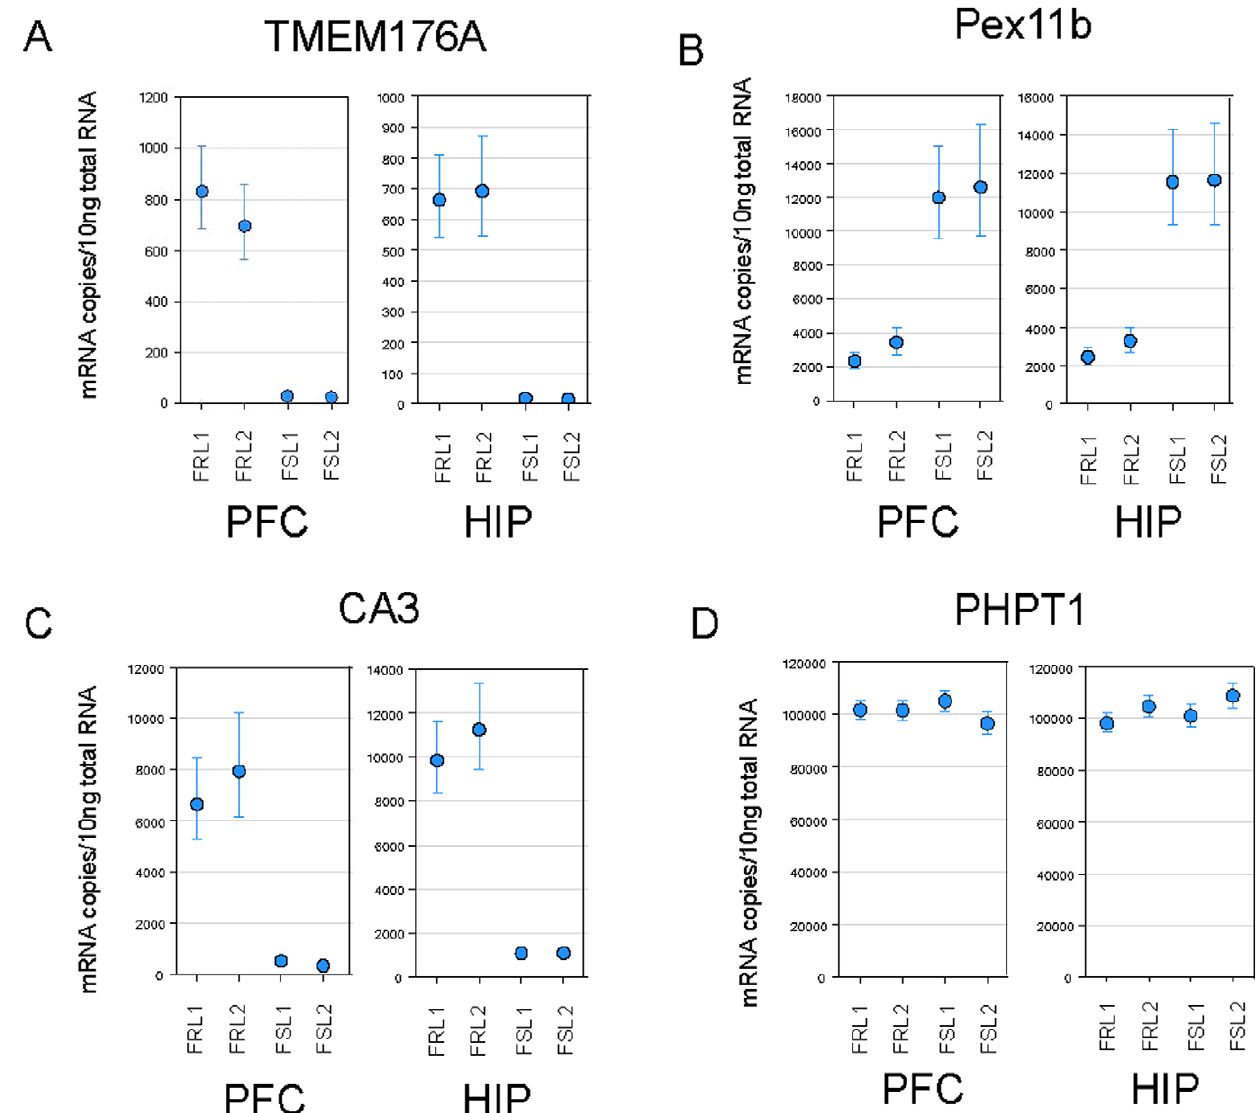
Figure 2. Examples of real-time PCR data. Group Least Squares Means were calculated in Array Studio and expressed as copy number/10ng of total RNA for FRL cohort 1 (FRL1), FRL cohort 2 (FRL2), FSL cohort 1 (FSL1) and FSL cohort 2 (FSL2) in P/FC and HIP. Data included for TMEM176A (A), Pex11b (B), CA3 (C) and invariant gene PHPT1 (D). Error bars represent 95% confidence intervals.